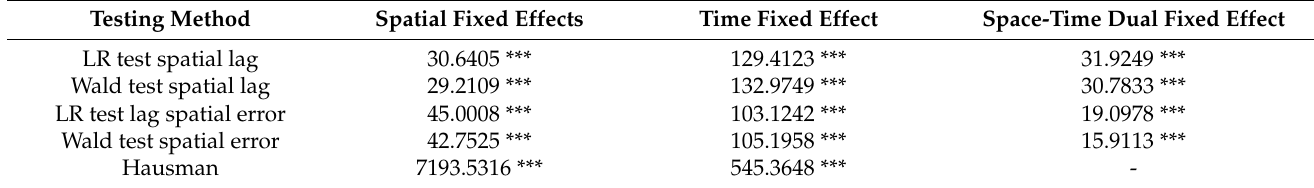
Table 4. Results of diagnosis and selection test of spatial measurement